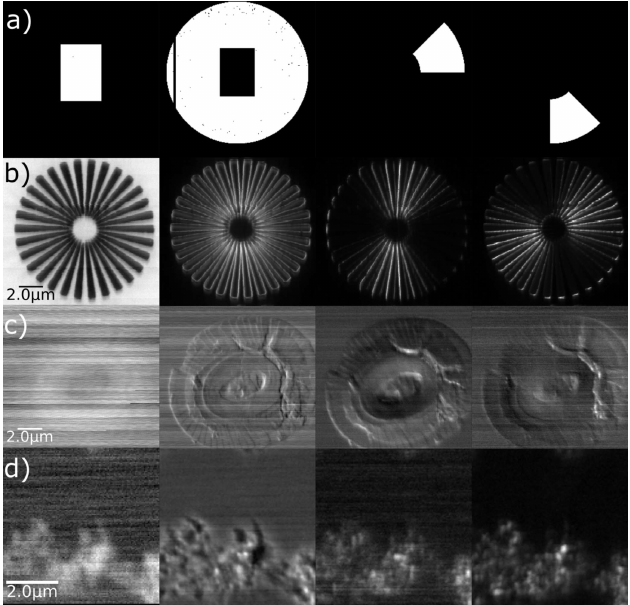
Figure 1 Intensity-based measurements extracted from the signal on the detector. ( a ) Left to right: masks for the extraction of absorption, scatter and example radially selected scatter intensities. ( b )–( d ) Left to right: corresponding absorption, scatter, and radially selected scatter intensities for ( b ) Siemens star, ( c ) coccolith, ( d ) drop-cast Fe